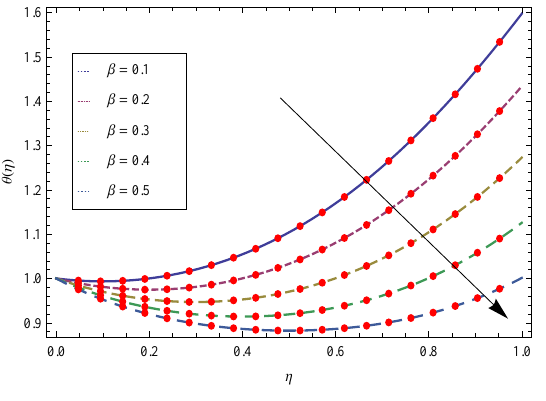
Figure 10. Indicates the effect of Kr on f ( η ) for h = − 0.25, S = 0.5,Pr = 0.5, λ = 1,Ec = 0.5, Nb = 0.5,Nt = 0.6, β = 1, Sc = 0.6.